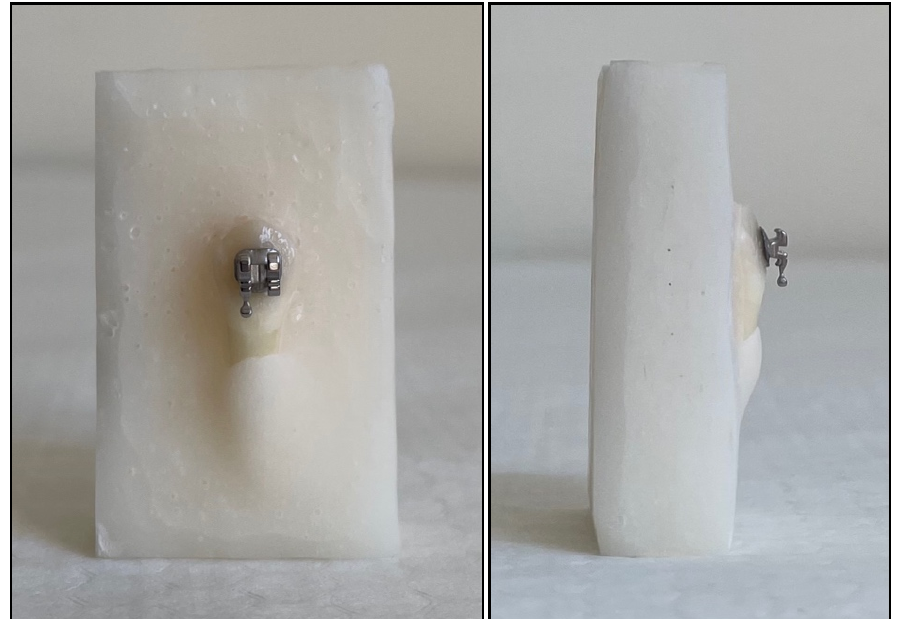
Figure 1. The buccal surfaces of the teeth are embedded perpendicular to the stainless-steel nozzle tip, which will exert the shear force. tip, which will exert the shear